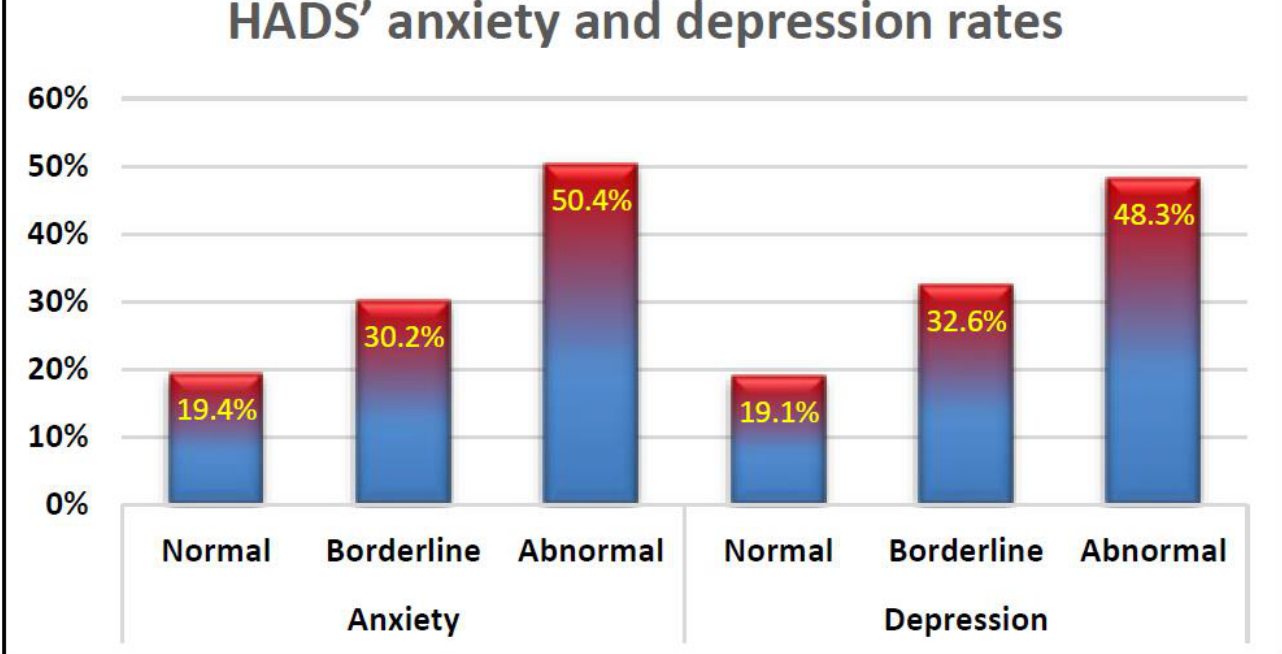
Figure 1. HADS anxiety and depression rates among participants from the UK MS